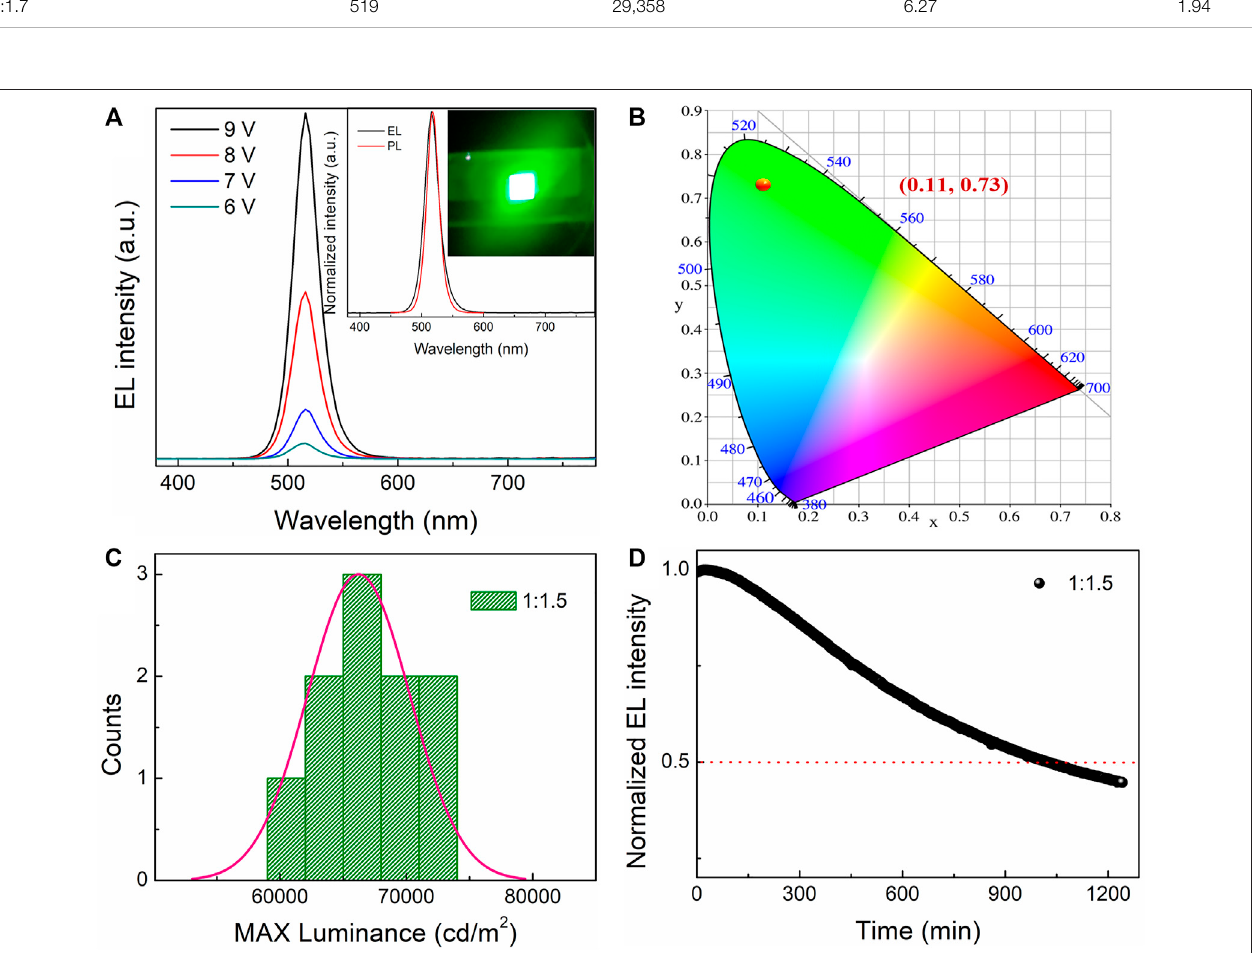
FIGURE 6 | (A) EL spectra of the PeLED device based on the all-inorganic perovskite fi lm with the molar ratio of PbBr 2 to CsBr = 1:1.5 operating under different applied voltages. The inset shows its normalized EL and PL spectra, as well as its digital photographs in operation at 6 V. (B) CIE chromaticity coordinate diagram, (C) histogram of maximum luminance, (D) stability test under continuously operational conditions for the PeLED device based on the all-inorganic CsPbBr 3 -Cs 4 PbBr 6 perovskite fi lm with the molar ratio of PbBr 2 to CsBr = 1:1.5.